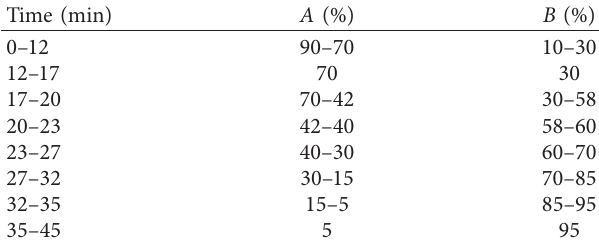
Table 2: The time program of gradient